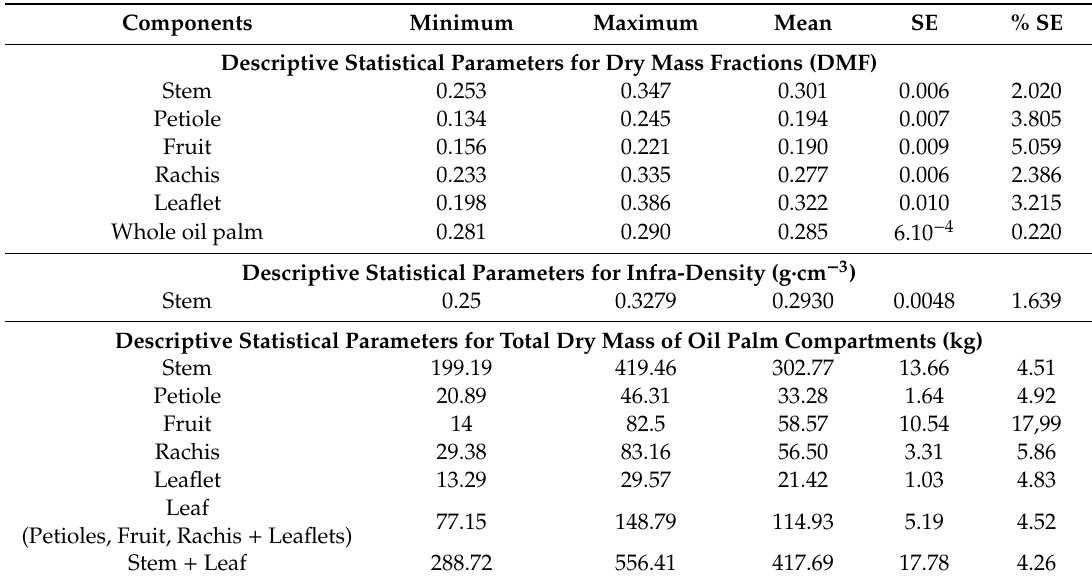
Table 2. Summary of the infra-density, dry mass fractions and the average total dry mass of the palm components for 18 individuals that were felled in Makouk é , central